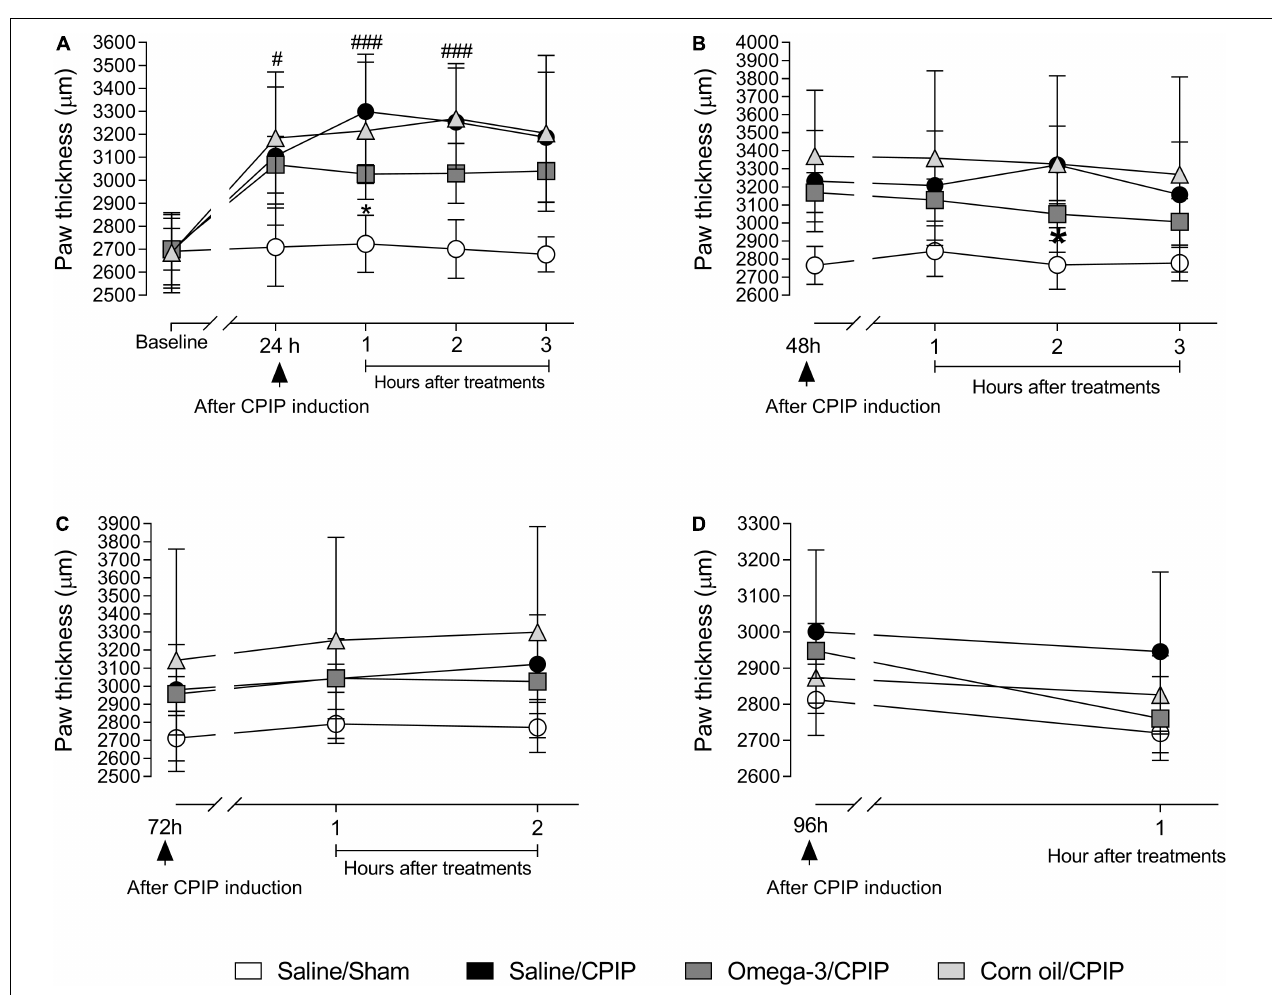
FIGURE 2 | Effects of omega-3 supplementation on paw edema post-CPIP induction. Paw thickness evaluations of animals in Saline/Sham ( n = 10), Saline/CPIP ( n = 9), Omega-3/CPIP, and Corn oil/CPIP ( n = 10) groups 1 day before the induction of the CPIP model (baseline, A ), and time course of the saline, omega-3, or corn oil treatments on days 1, 2, 3, and 4 after model induction (A–D) . Assessments at 24 (A) and 48 h (B) post-injury, and 1, 2, and 3 h post-treatment. Time course up to 2 h post-treatment, 72 h after the induction of CPIP (C) . Paw thickness at 96 h post-CPIP and 1 h post-treatment (D) . Data are expressed as mean ± SD compared using the two-way ANOVA with repeated measurements followed by Tukey’s test. # p < 0.05 and ### p < 0.0001 vs. Saline/Sham group; ∗ p < 0.05 vs. Saline/CPIP